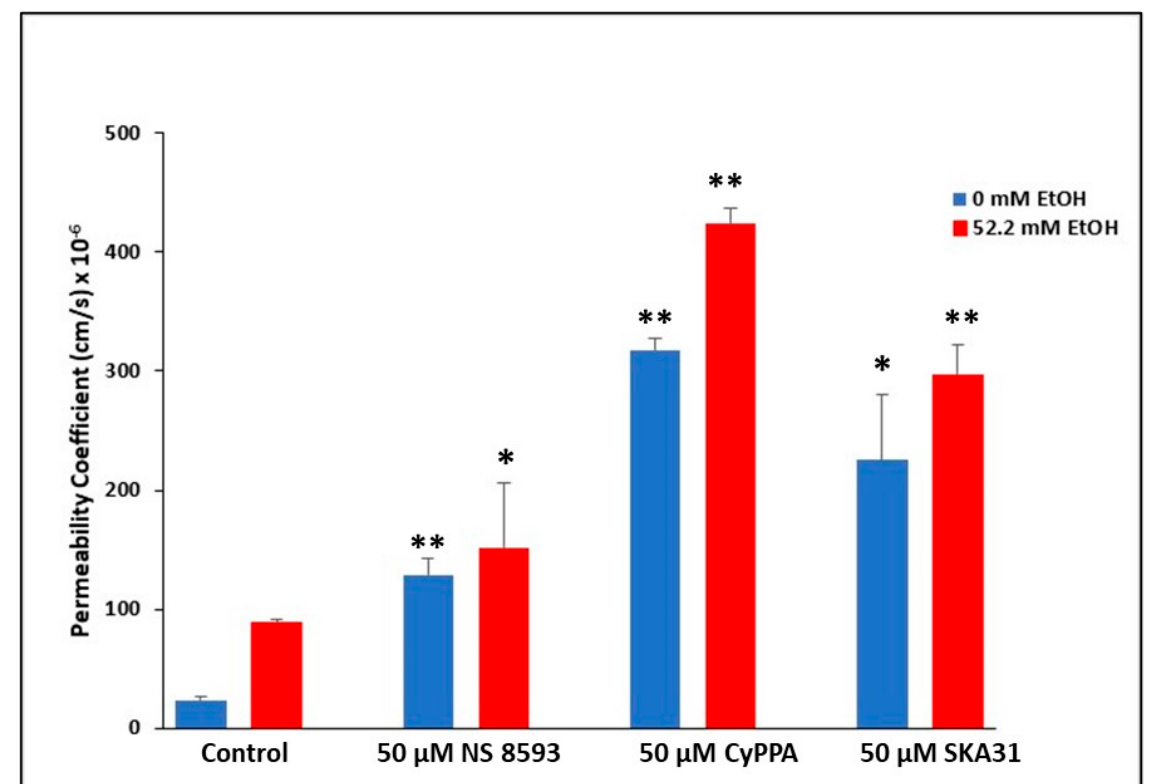
Figure 4. Rat BMVEC in vitro BBB model. Passage 5 isolated rBMVECs were seeded into Corning transwell plate inserts and grown for three days, to allow a barrier to form as confirmed by Transendothelial Electrical Resistance (TEER) measurements. Media only was added to wells to account for background. BMVECs were treated with either 0 or 52.2 mM EtOH, as well as TRPM7 antagonists, NS 8593, CyPPA, or SKA31 in both 0 and 52.2 mM EtOH treatment conditions. Ten µ g/mL of Sodium Fluorescein (NaF) was added to each insert for permeability assessment prior to assay incubation at 37 ◦ C for 24 h. Permeability coefficient was calculated, along with p -value by Student’s t test. * p < 0.05, ** p < 0.01.